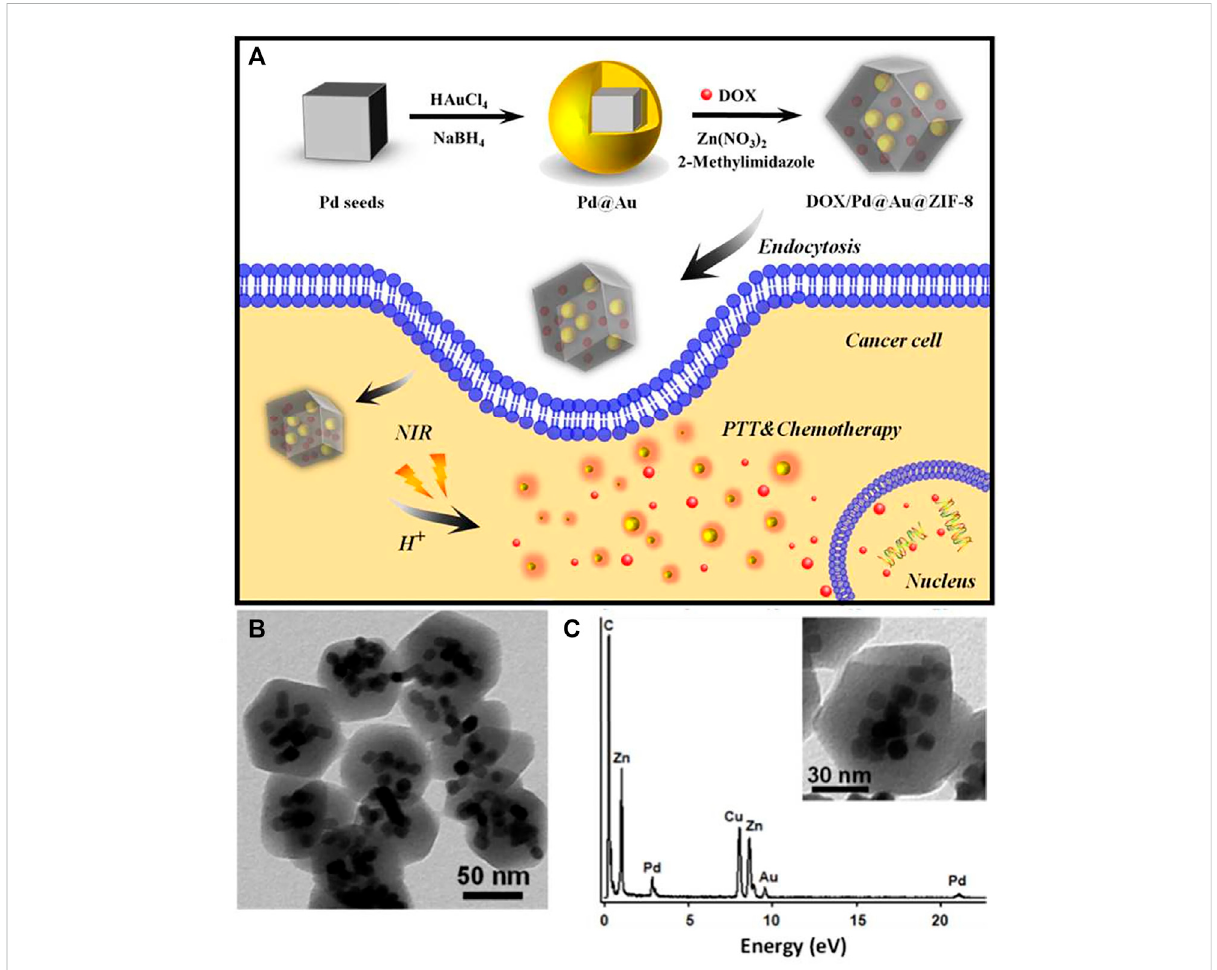
FIGURE 8 (A) DOX/Pd@Au@ZIF-8 and its application in pH and near-infrared-triggered chemotherapy photothermal synergistic treatment of cancer cells; (B) DOX/Pd@Au@ZIF-8 TEM images; (C) DOX/Pd@Au@ZIF-8 TEM-associated EDX spectra. Adapted with permission from Yang et al.